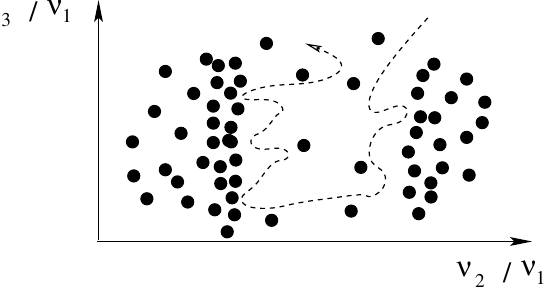
FIG. 2. Diffusion for a system of 3 degrees of freedom such as the transverse dynamics in an accelerator. Although not confined by regular trajectories (dots), the diffusion is never- theless very slow in their neighborhood (from